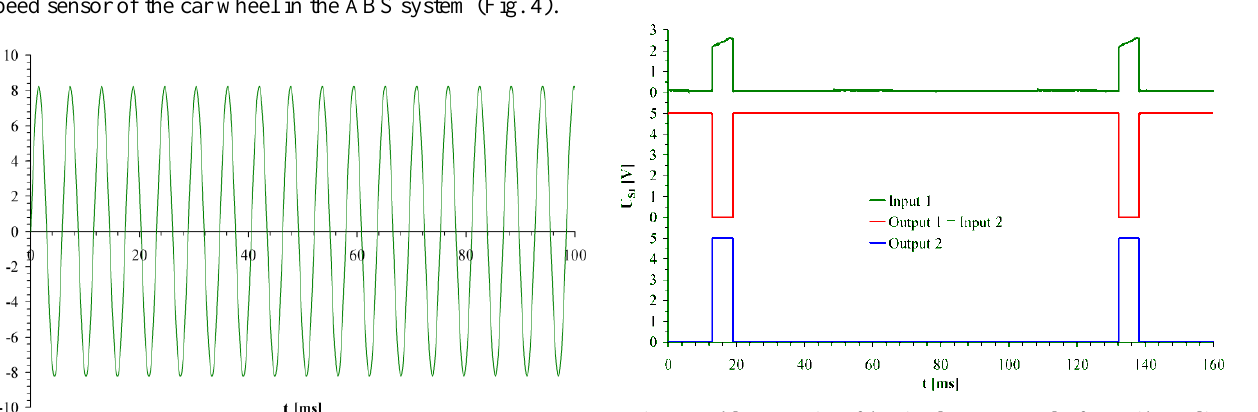
Fig. 7. Double conversion of the signal to a rectangular form with ampli- tude adjustment up to 5